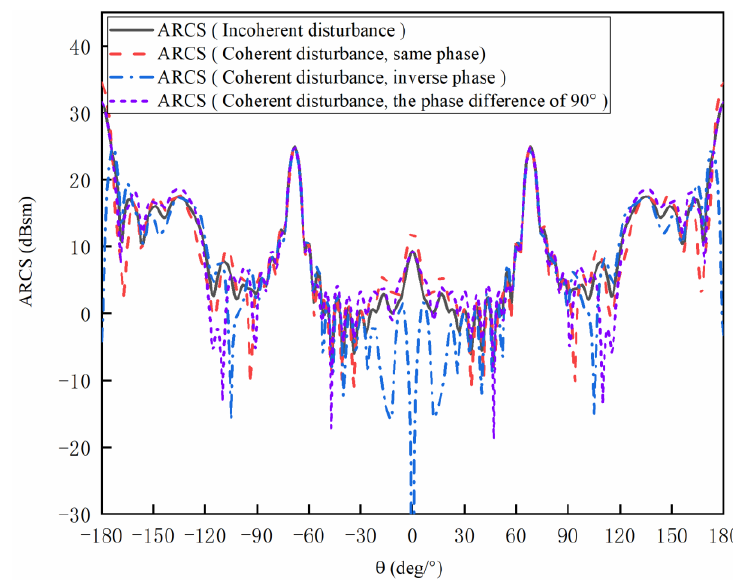
Figure 10. Coherent external disturbances and incoherent external disturbances of the prismatic model.